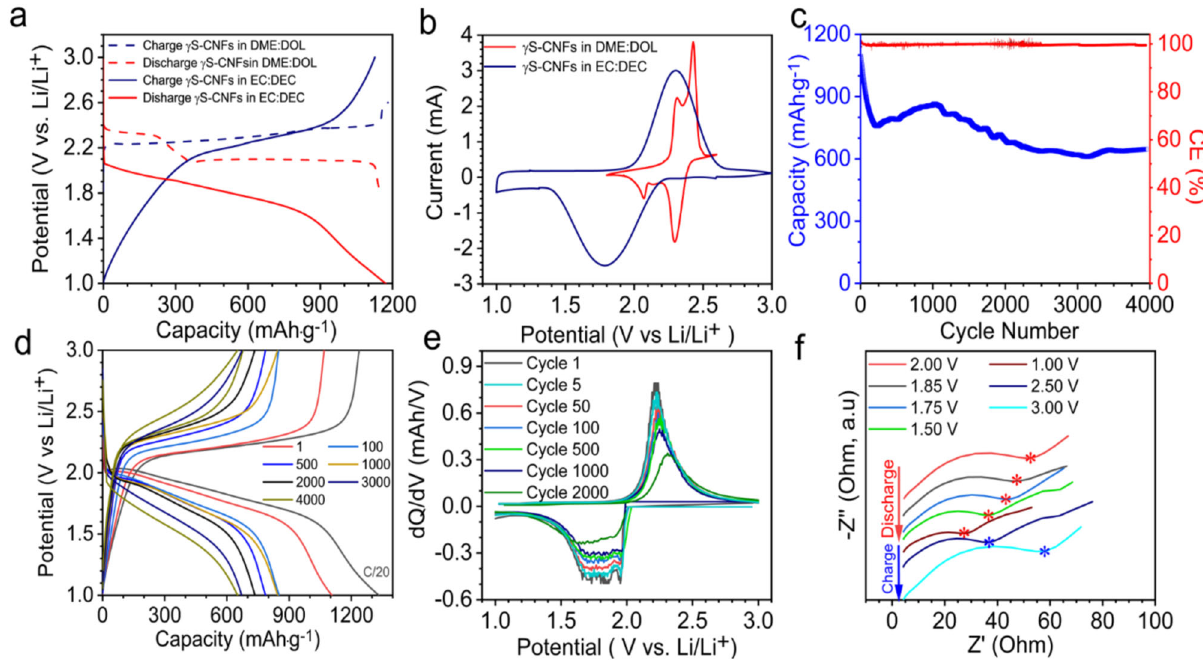
Fig. 4 Electrochemical characterization γ S-CNFs. a Charge – discharge patterns of γ S-CNFs in ether electrolyte (DME: DOL) and carbonate electrolyte (EC: DEC). b Cyclic voltammetry curves of γ S-CNFs in ether electrolyte (DME: DOL) and carbonate electrolyte (EC: DEC) at 0.1 mV·s − 1 . c Cycling stability of γ S-CNFs in EC: DEC at a current rate of 0.5 C. d The charge – discharge pro fi les of γ S-CNFs at various cycle numbers. e Differential capacity analysis plot of γ S-CNFs displaying a single peak in the charge – discharge cycle. f Nyquist plot of γ S-CNFs cathode as a function of voltage during the charge – discharge cycle. The cells were assembled with S loading of 0.5 mg·cm − 2 using ~50 wt% sulfur in the cathode and an E/S ratio of